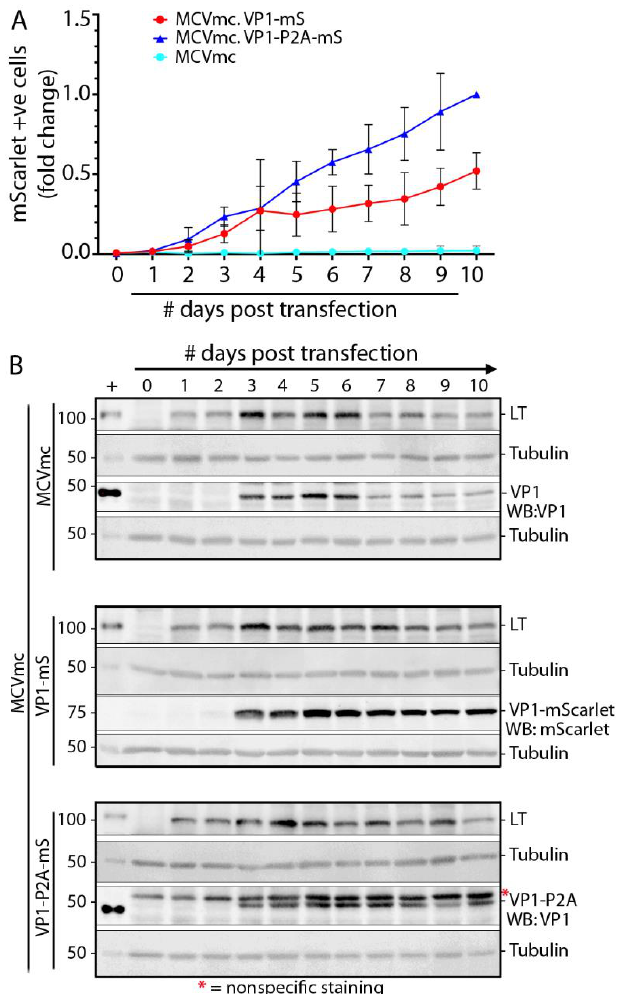
Figure 5. MCV replication kinetics analysis using mScarlet reporter. ( A ) Numbers of mScarlet-positive cells in 293 cells transfected with MCVmc, MCVmc.VP1-mS, or MCVmc VP1-P2A-mS from day 1 through day 10 post transfection were quantified by flow cytometry. Data were normalized to MCVmc.VP1-P2A-mS day 10 post transfection. Error bars indicate ± SD of three independent experiments. ( B ) Immunoblot of MCV-encoded proteins (LT and VP1) or mScarlet in 293 cells transfected with MCVmc, MCVmc.VP1-mS, and MCVmc. VP1-P2A-mS from 1 to 10 days post transfec-